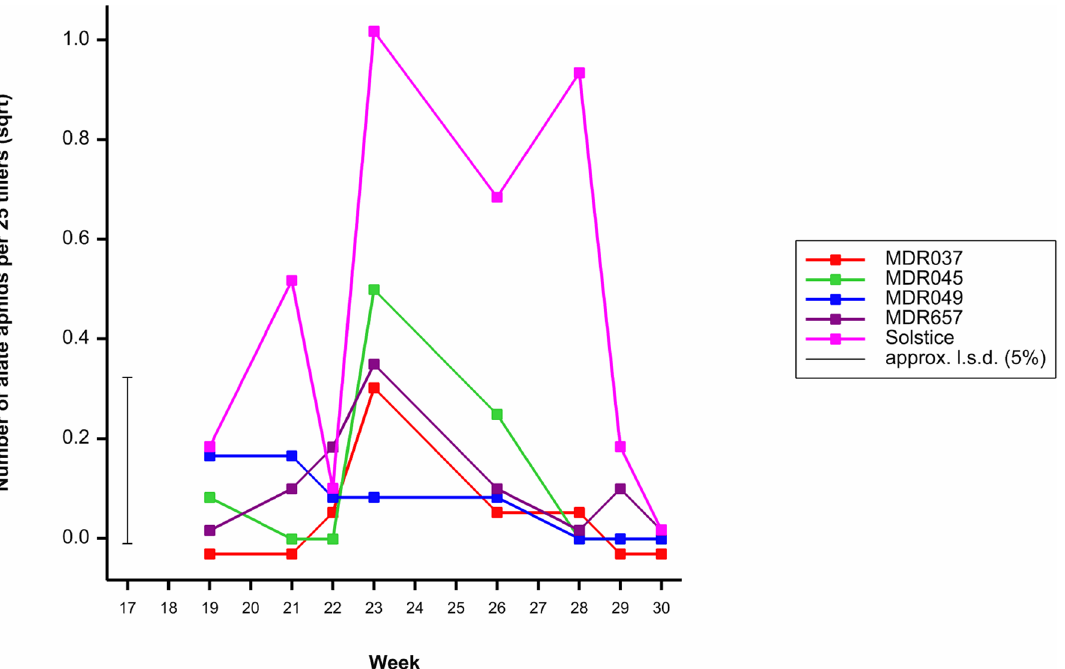
Figure 4. The average number of alate aphids observed on Triticum aestivum Solstice, Triticum moncoccum MDR037, MDR657, MDR045 and MDR049 from week 18 to week 30 across all three field trials. All data was subject to square root transformation.